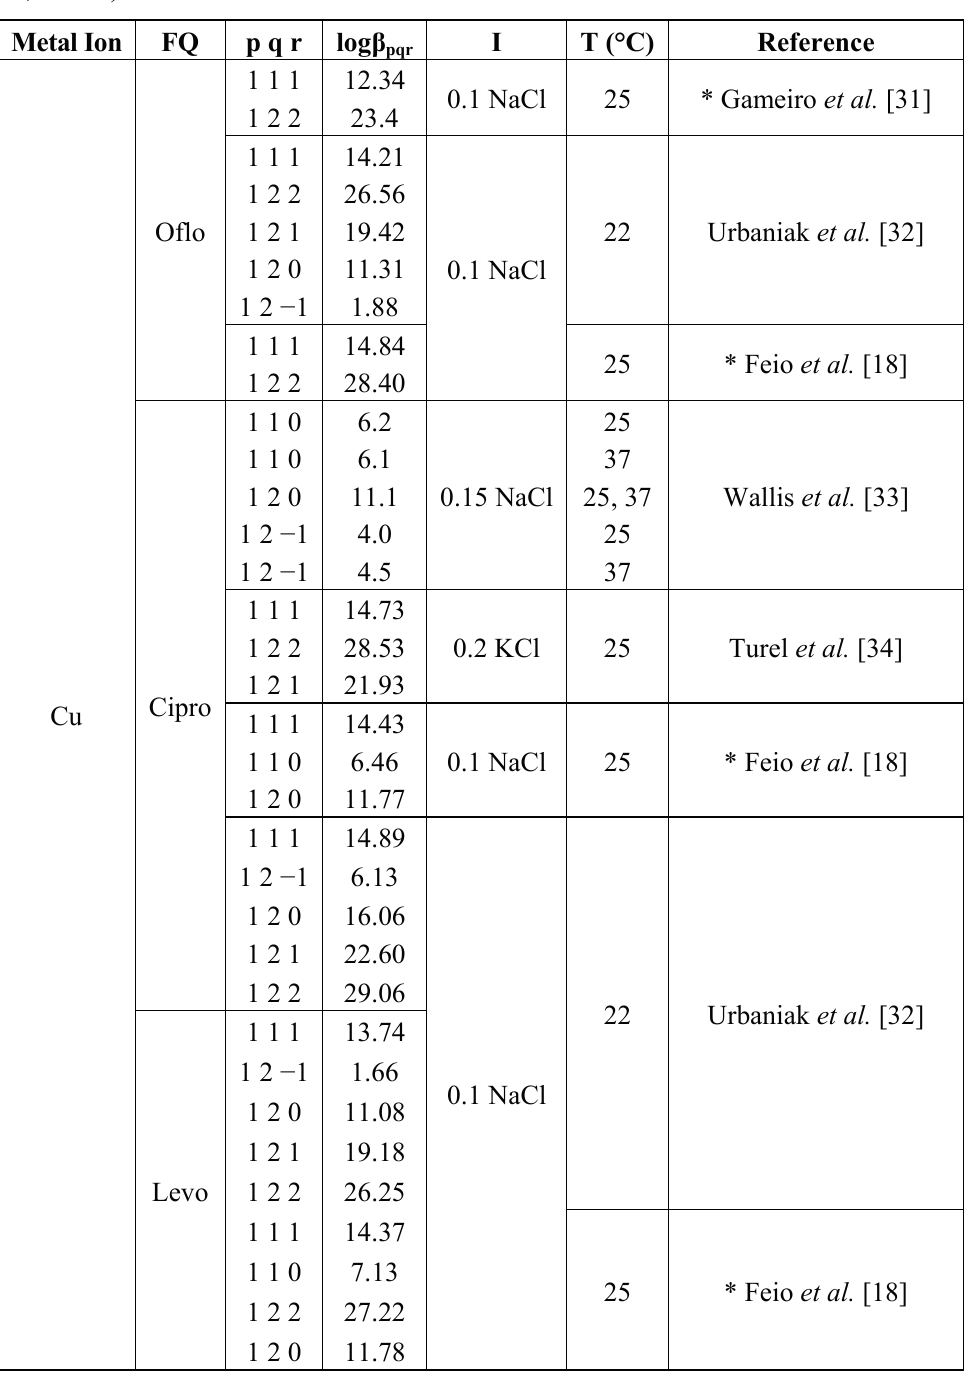
Table 4. Literature overview of stability constants of the complexes M from potentiometric measurements data of M(II)-FQ systems (I = ionic strength of the medium,